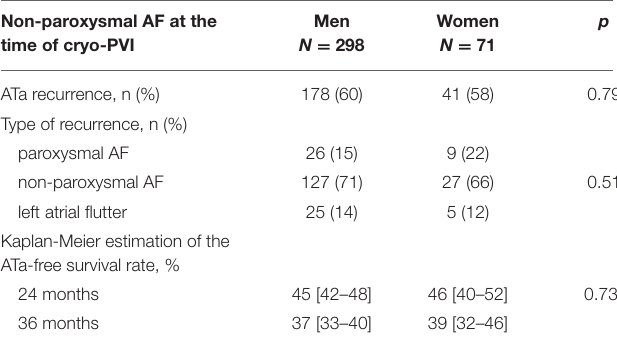
TABLE 5 | Sex differences in outcomes after an index cryo-PVI for non-paroxysmal AF. Non-paroxysmal AF at the time of